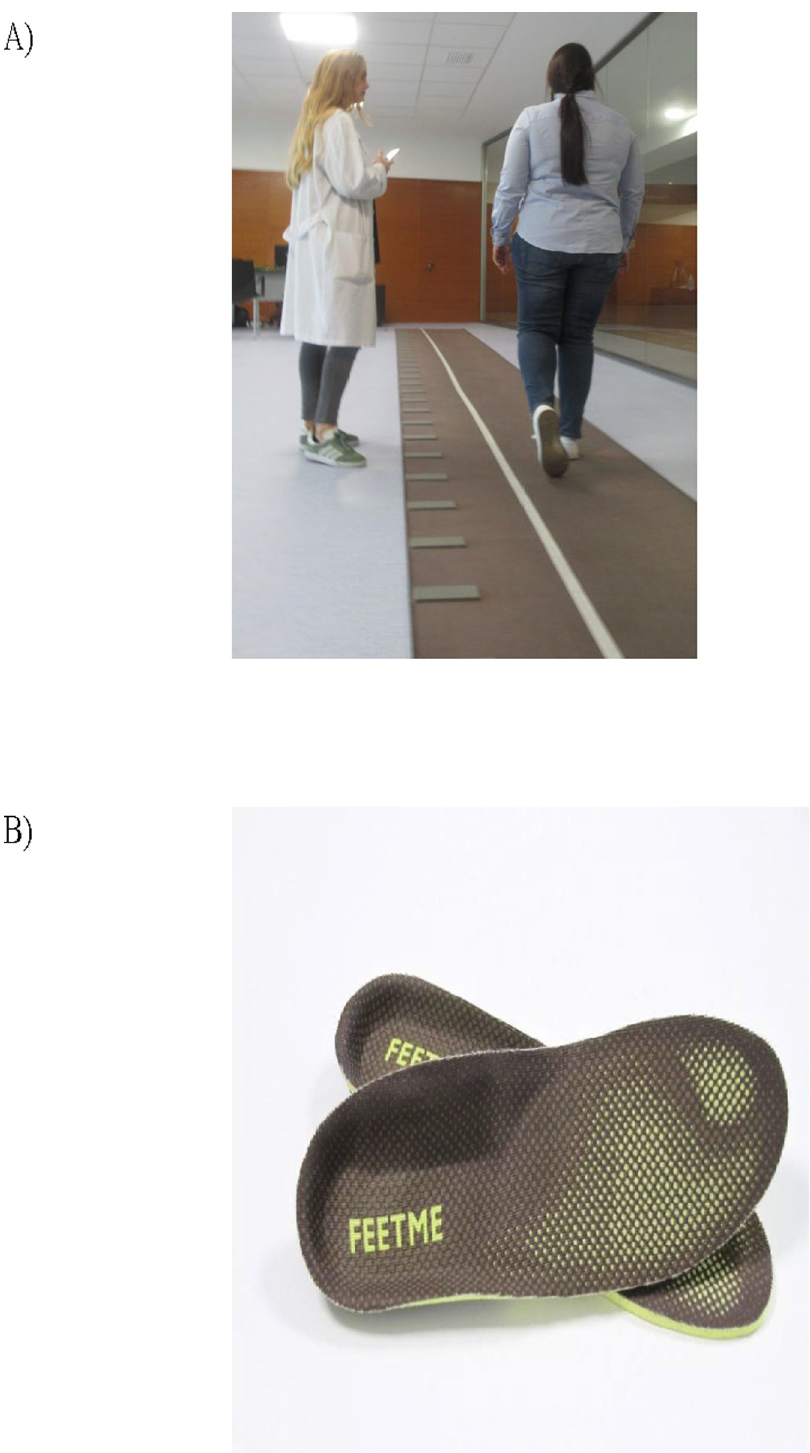
Fig 1. Devices to measure gait parameters (A) GAITRite 1 and (B) FeetMe 1 Monitor.